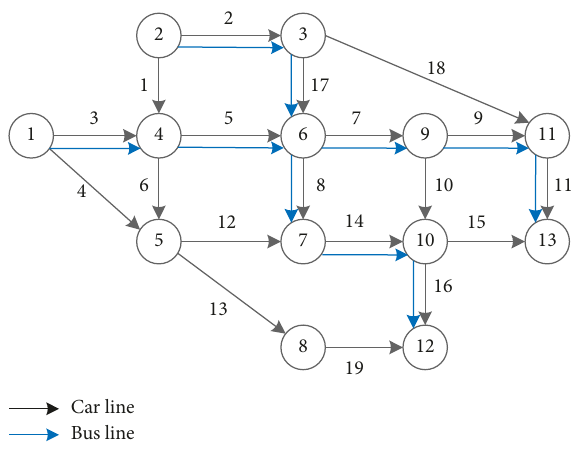
Figure 1: Extended Nguyen-Dupuis network